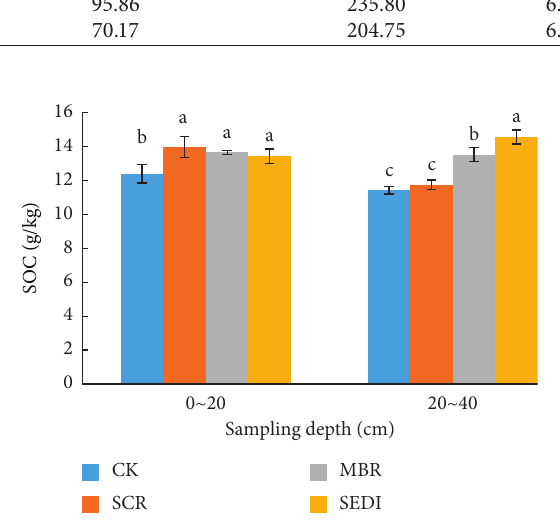
Figure 1: Effect of different treatments of corn straw on SOC.